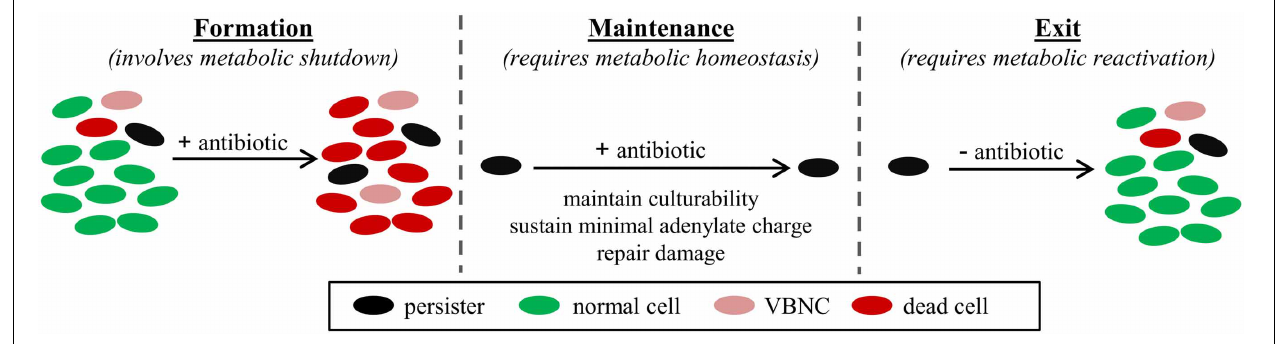
FIGURE 1 | Persister metabolic program. Persisters can be pre-existing in a bacterial population (Balaban et al., 2004), formed in response to stress, such as stresses that activate the stringent response (Amato et al., 2013), and induced during antibiotic treatment (Dörr et al., 2009; Orman and Brynildsen, 2013a). Maintenance of the persister state for the duration of the antibiotic treatment requires temporary inhibition of